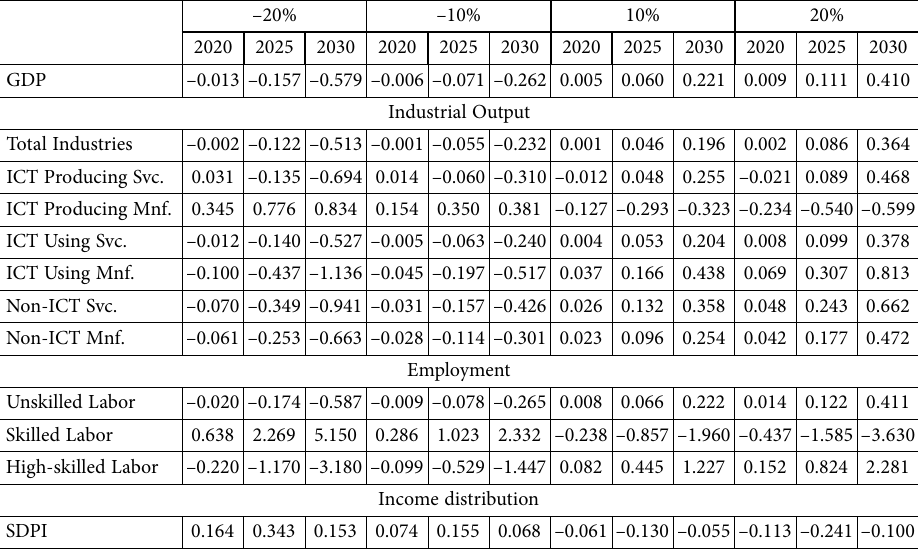
Table B1. Major variables under alternative elasticity of substitution between ICT capital and skilled labor ( s